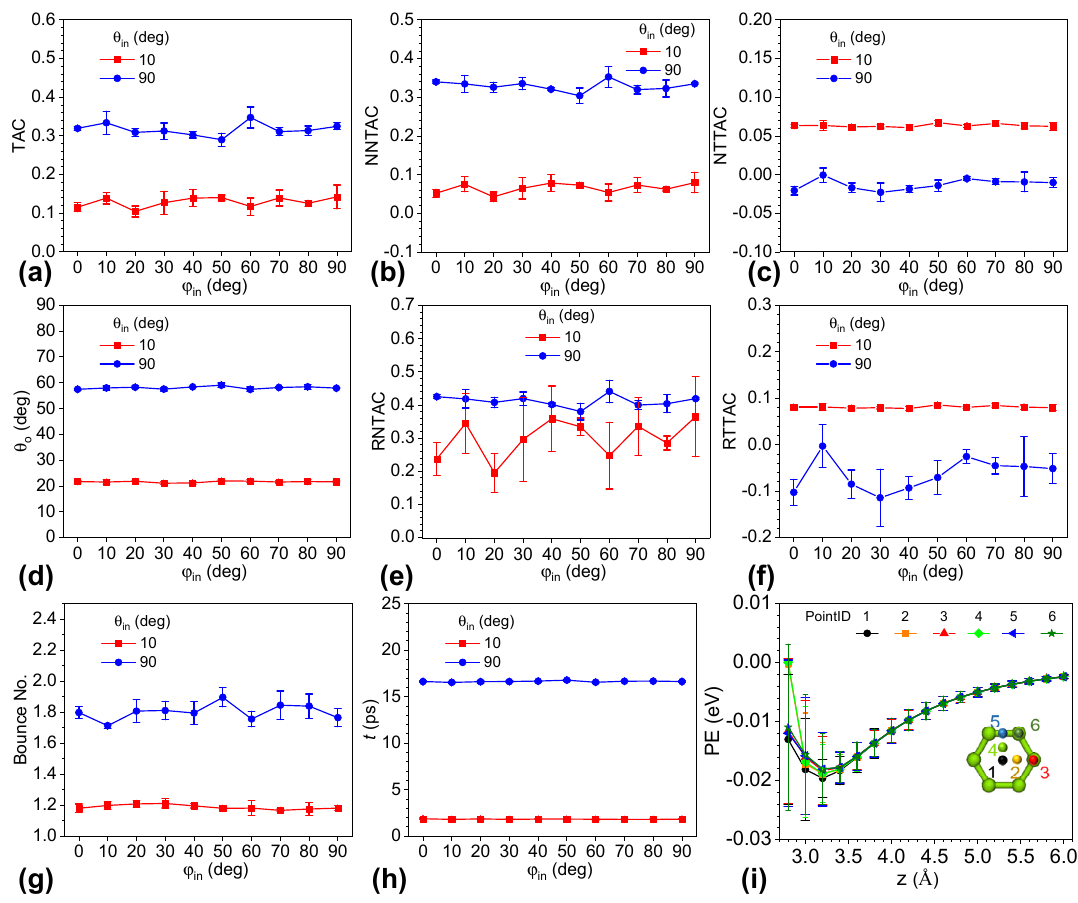
Figure 3. ( a ) TAC, ( b ) NNTAC, ( c ) NTTAC, ( d ) zenith angle of the scattered helium ( θ o ), ( e ) RNTAC, ( f ) RTTAC, ( g ) bounce number of helium, ( h ) total collision time versus azimuthal angle of the incident helium with the zenith angles at 0° and 90°, respectively. ( i ) Potential energy of the helium atom at six different in-plane locations versus distance of helium atom from the graphene surface. The inset indicates the six in-plane locations of helium atoms.